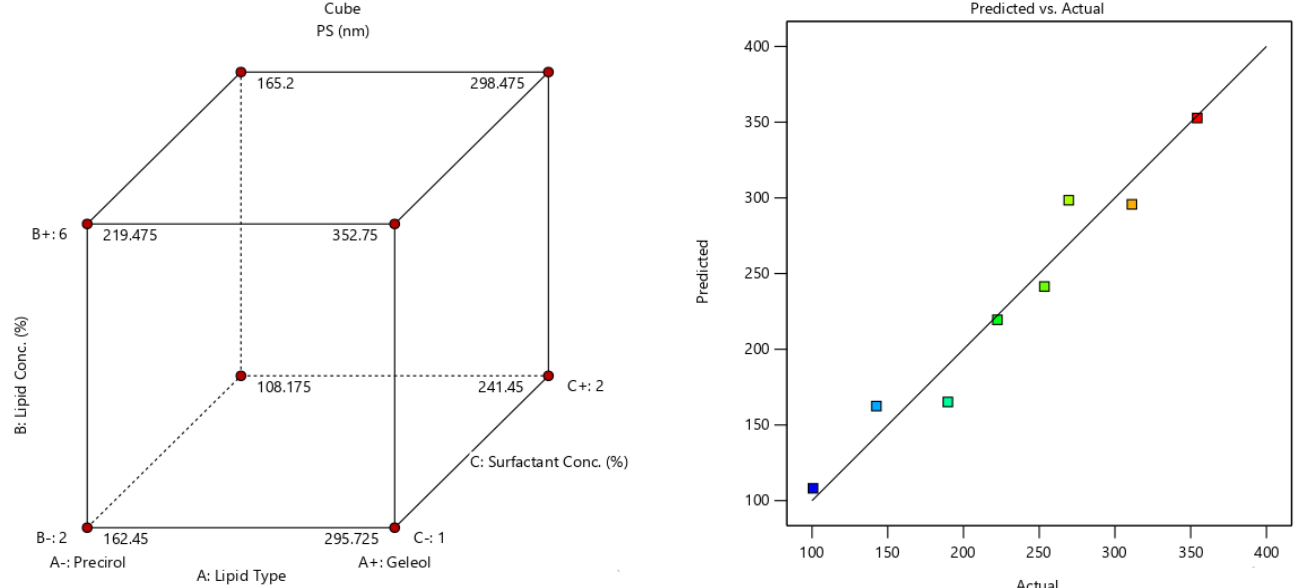
Figure 12. The impact of A: Lipid type, B: Lipid conc., C: surfactant conc. on PS of 4h-loaded NLC is represented in cubic plot and predicted versus actual values plot.